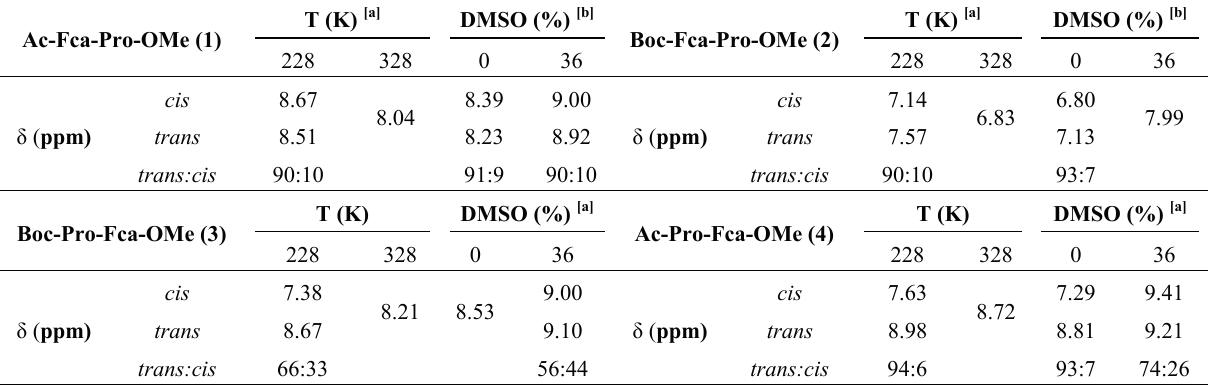
Table 5. The trans-cis ratios of imide bonds of peptides 1 – 4 measured by 1